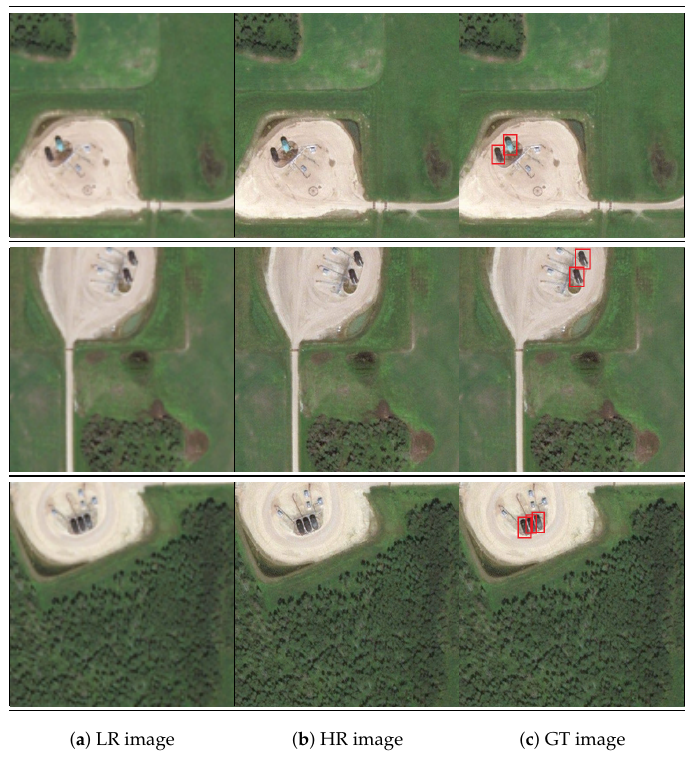
Figure 7. OGST (oil and gas storage tank) dataset: LR-HR (low-resolution and high-resolution) image pairs are shown in ( a , b ) and GT (ground truth) images with bounding boxes for oil and gas storage tanks are in ( c